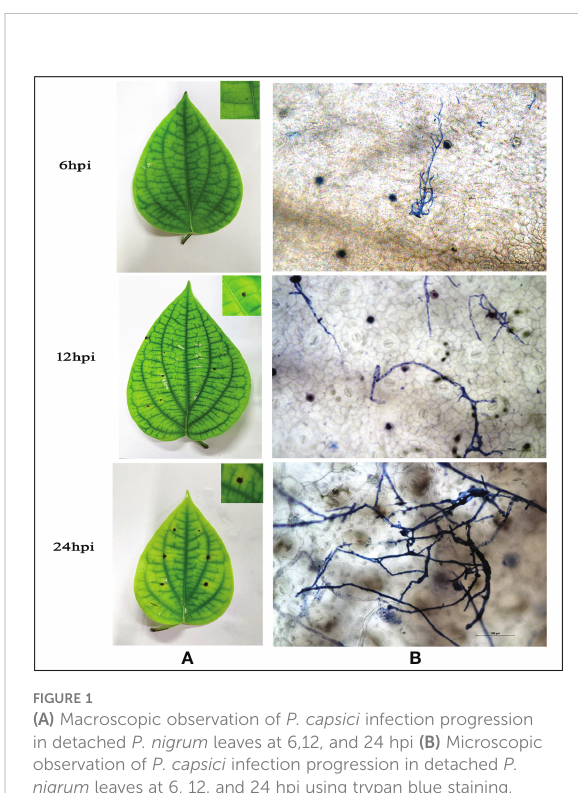
FIGURE 1 (A) Macroscopic observation of P. capsici infection progression in detached P. nigrum leaves at 6,12, and 24 hpi (B) Microscopic observation of P. capsici infection progression in detached P. nigrum leaves at 6, 12, and 24 hpi using trypan blue staining, visualized under 20X magni fi cation, Scale bar: 100 m